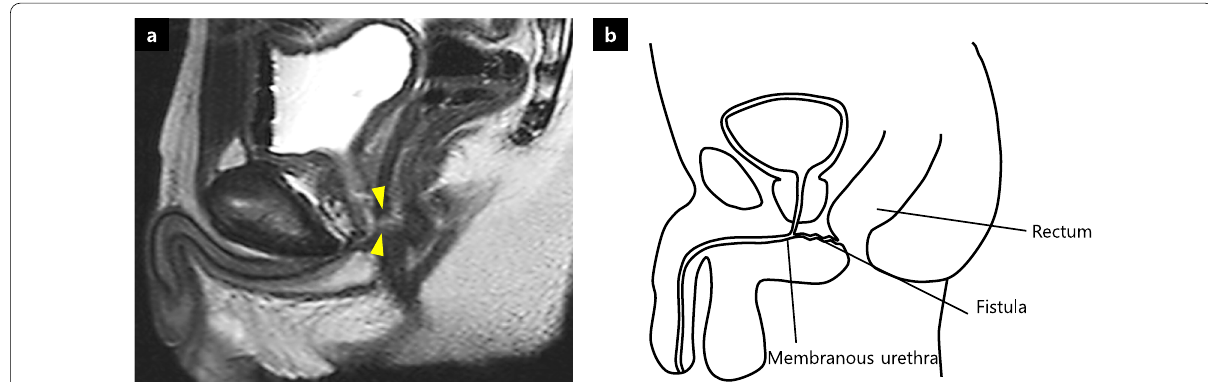
Fig. 1 Preoperative images of rectourethral fistula. a Preoperative magnetic resonance imaging revealed a fistula between the posterior membranous urethra and the lower anterior rectum (yellow arrowhead). b Illustration of the rectourethral fistula